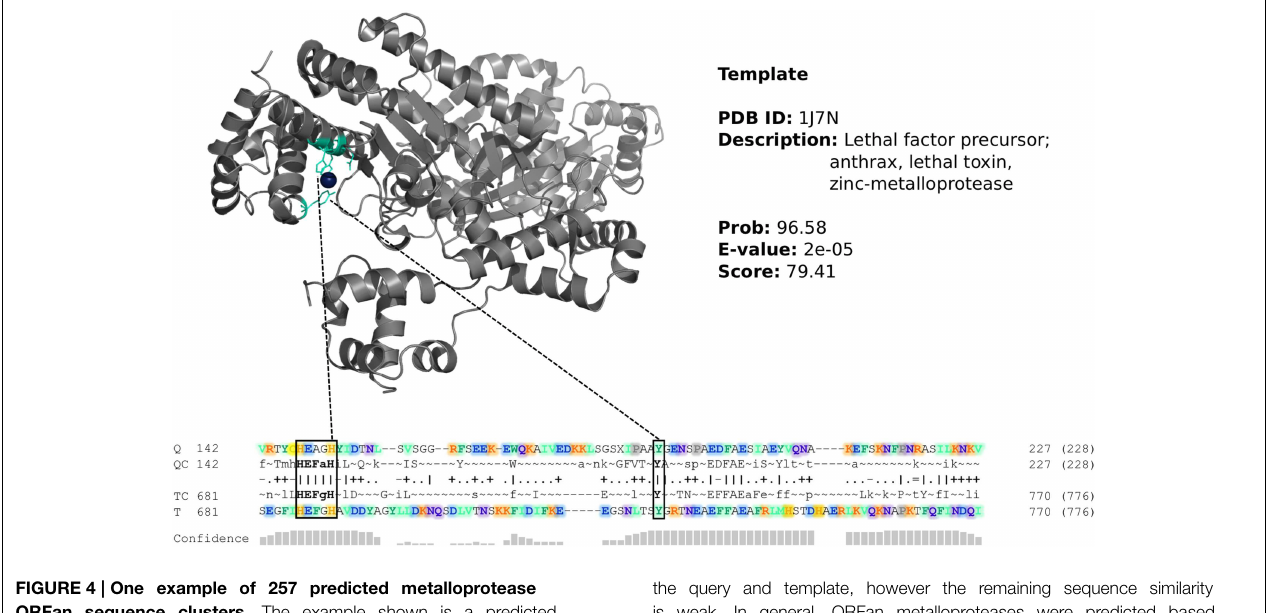
FIGURE 4 | One example of 257 predicted metalloprotease ORFan sequence clusters. The example shown is a predicted metalloprotease ORFan from the HG metagenome with similarity to the protease domain of the anthrax toxin. The catalytic zinc-metalloprotease (HExxH) catalytic motif is conserved between